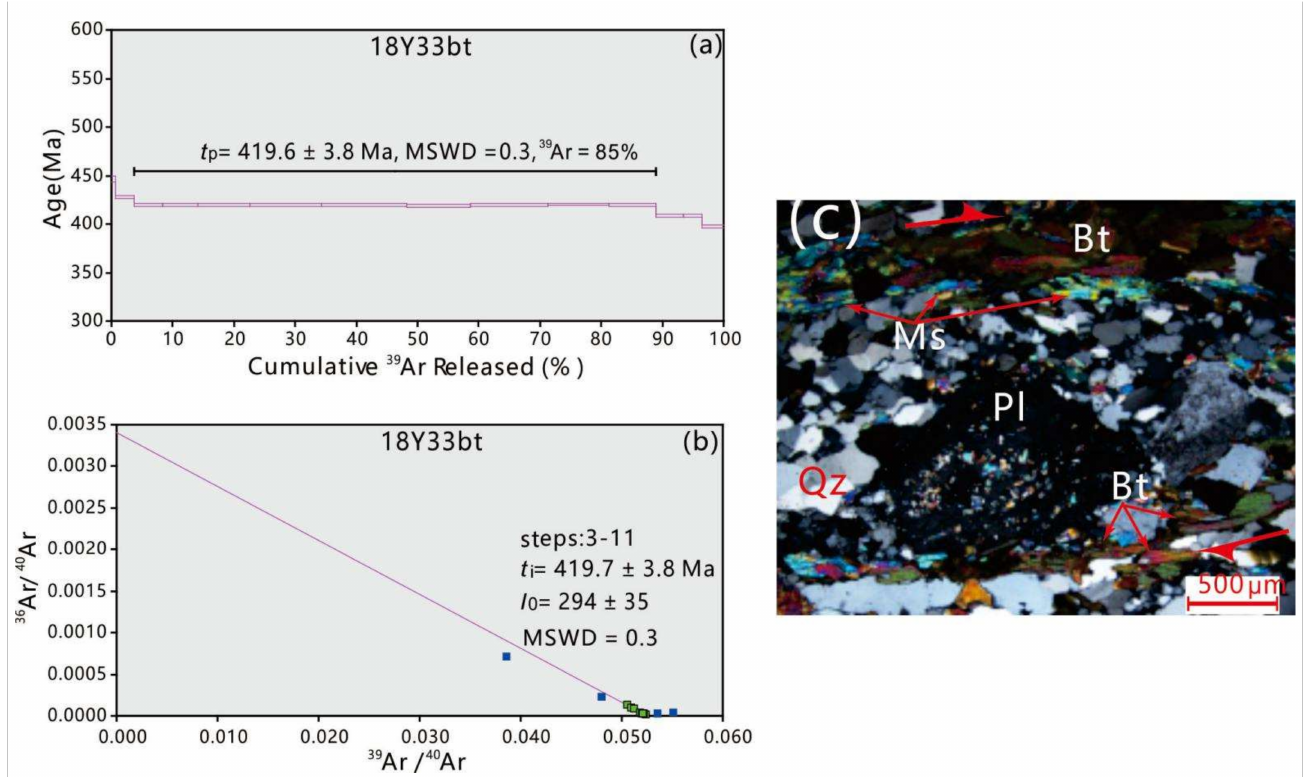
Figure 6. ( a ) Age spectrum and ( b ) inverse isochron for biotite (18M33Bt) from the mylonitic granite obtained by laser stepwise heating. ( c ) σ -type fabric and core–mantle structure of a (Pl) plagioclase porphyroblast surrounded by dynamically recrystallized (Ms) muscovite and (Bt) biotite, which are indicative of dextral